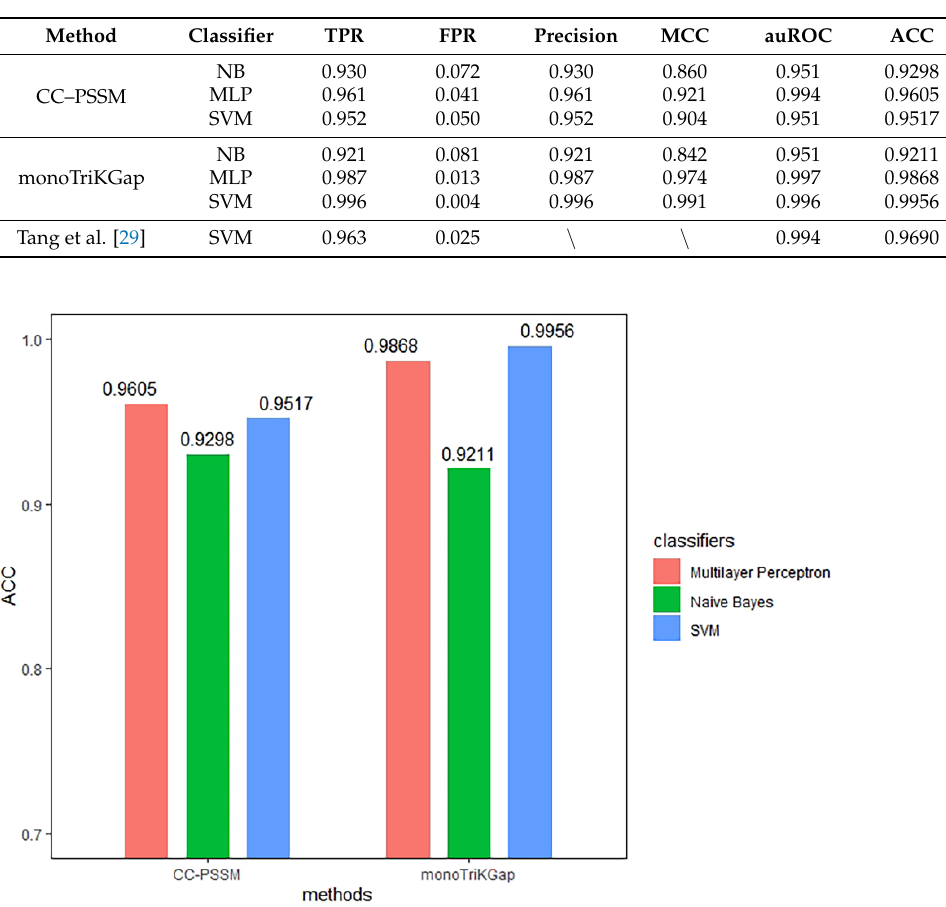
Table 2. Compare the results of different feature methods under different classifiers.